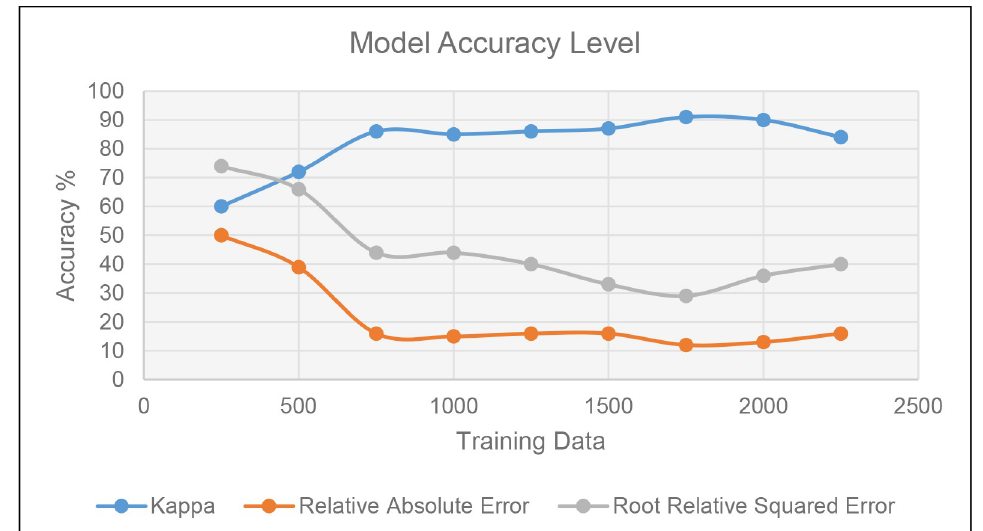
Fig 13. Validation results based on training data.